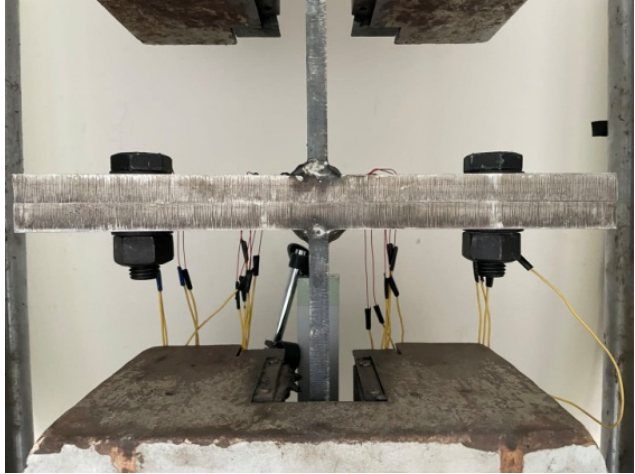
Figure 6. Setup for tensile testing.